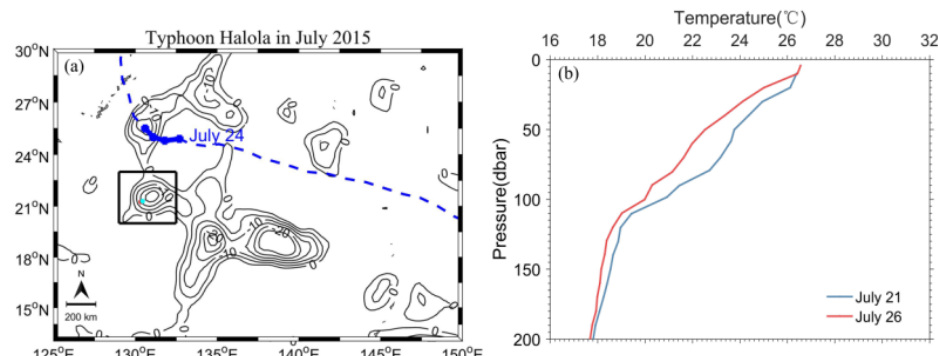
Figure 12. ( a ) The track (blue dashed line) of Typhoon Halola in July 2015. The blue dot denotes typhoon center on 24 July. Overlaid is SSHA (contours, unit: cm) on 21 July. Only negative values are plotted. The black rectangle represents the same CE region as shown in Figure 2. ( b ) Vertical temperature profiles observed by the Argo float inside the CE before (on 21 July) and after Halola (on 26 July).